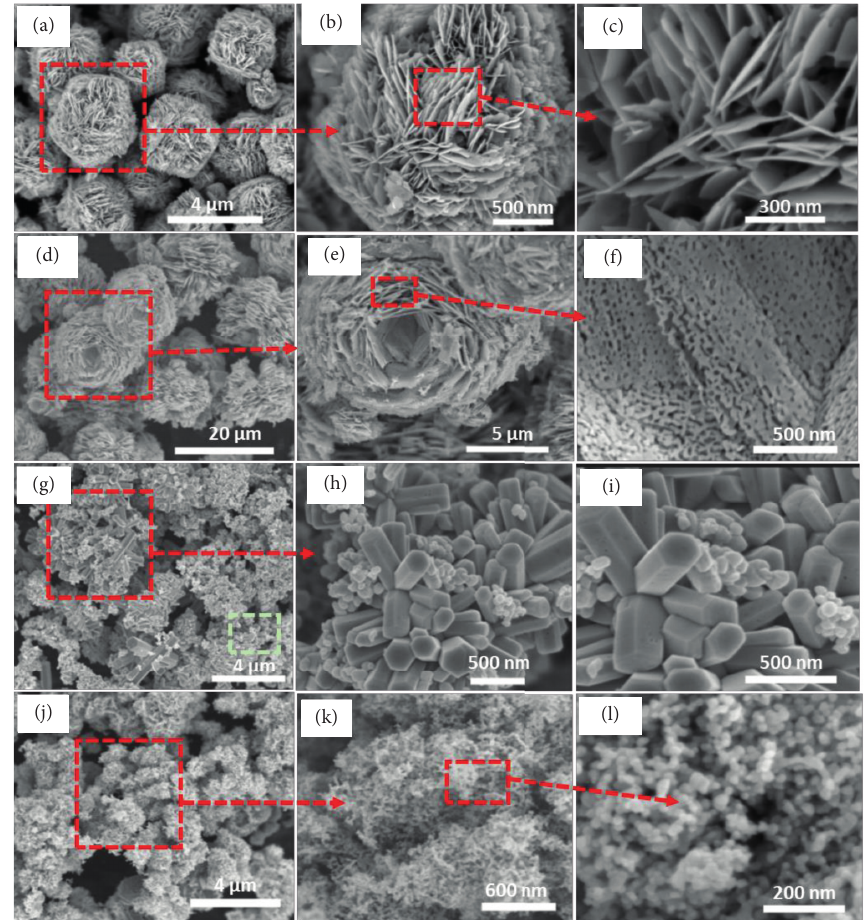
Figure 1: SEM images of the as-synthesized samples at the different scale bars: (a–c) CF-ZnO; (d–f) RF-ZnO; (g–i) R-ZnO; and (k–l) N-